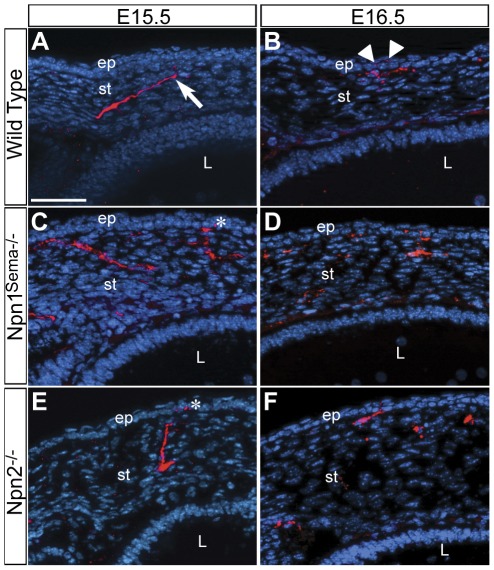
Timing of the innervation of the corneal epithelium is disrupted in Npn1Sema−/− and Npn2−/− mutants.Cross sections of E15.5–E16.5 (A–B) Wild type, (C–D) Npn1Sema−/−, and (E–F) Npn2−/− corneas immunostained with TuJ1 and counterstained with DAPI. In wild type corneas, axons projection toward the epithelium at E15.5 (A) and innervate it at E16.5 (B). The corneal epithelium is innervated by E15.5 in Npn1Sema−/− (C, asterisk) and Npn2−/− (E, asterisk) mutant corneas. Scale bar: 50 µm.